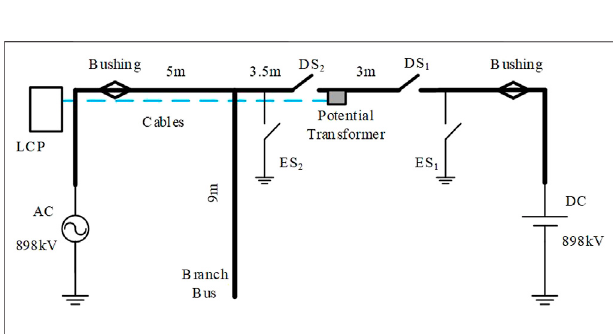
FIGURE 6 | UHV GIS test